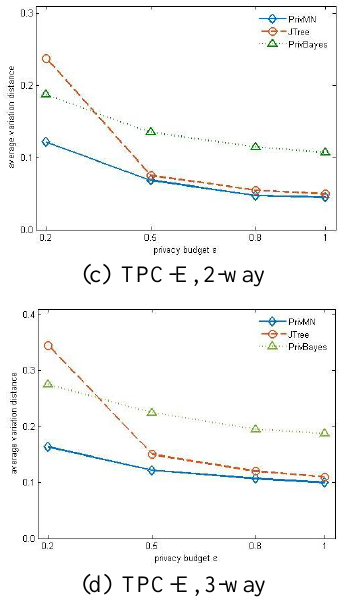
Fig.5. Total variation distance of k-way marginal tables on non-binary datasets